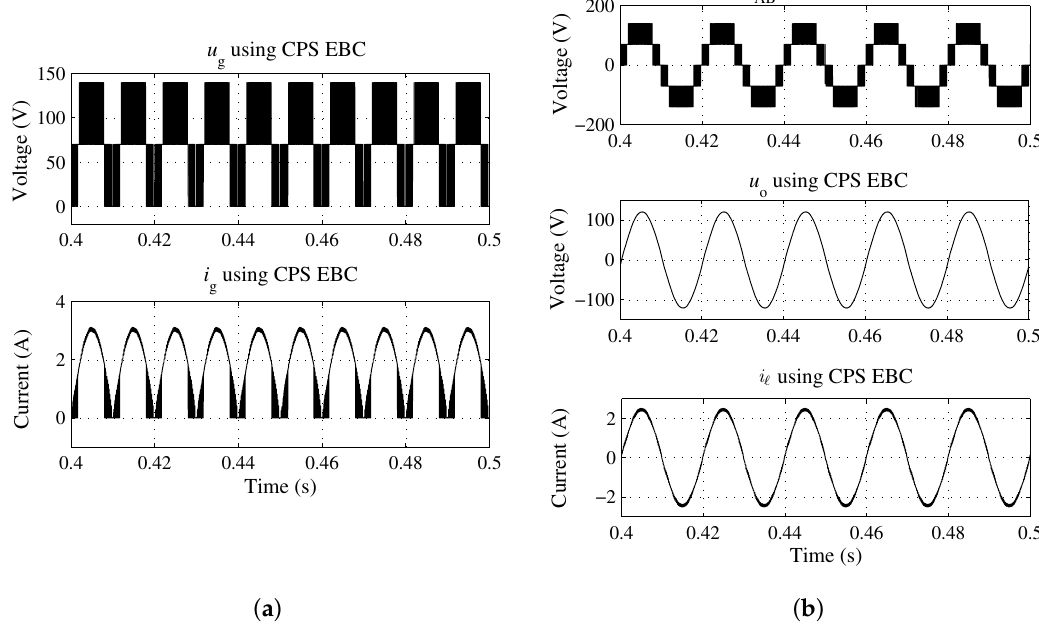
Figure 6. The simulation results of the five-level prototype. ( a ) The output voltage u g and current i g of the first stage; ( b ) The output voltage u o and current i o of the second stage.